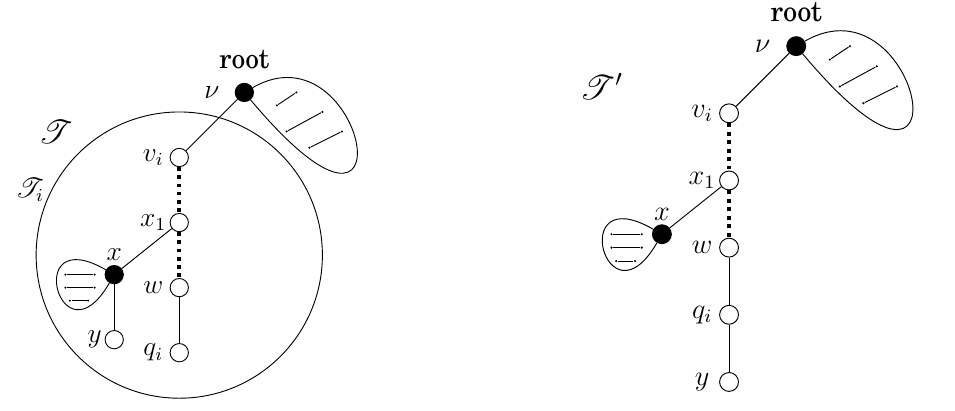
Figure 2: The trees T and T (cid:48) used in the proof of Lemma